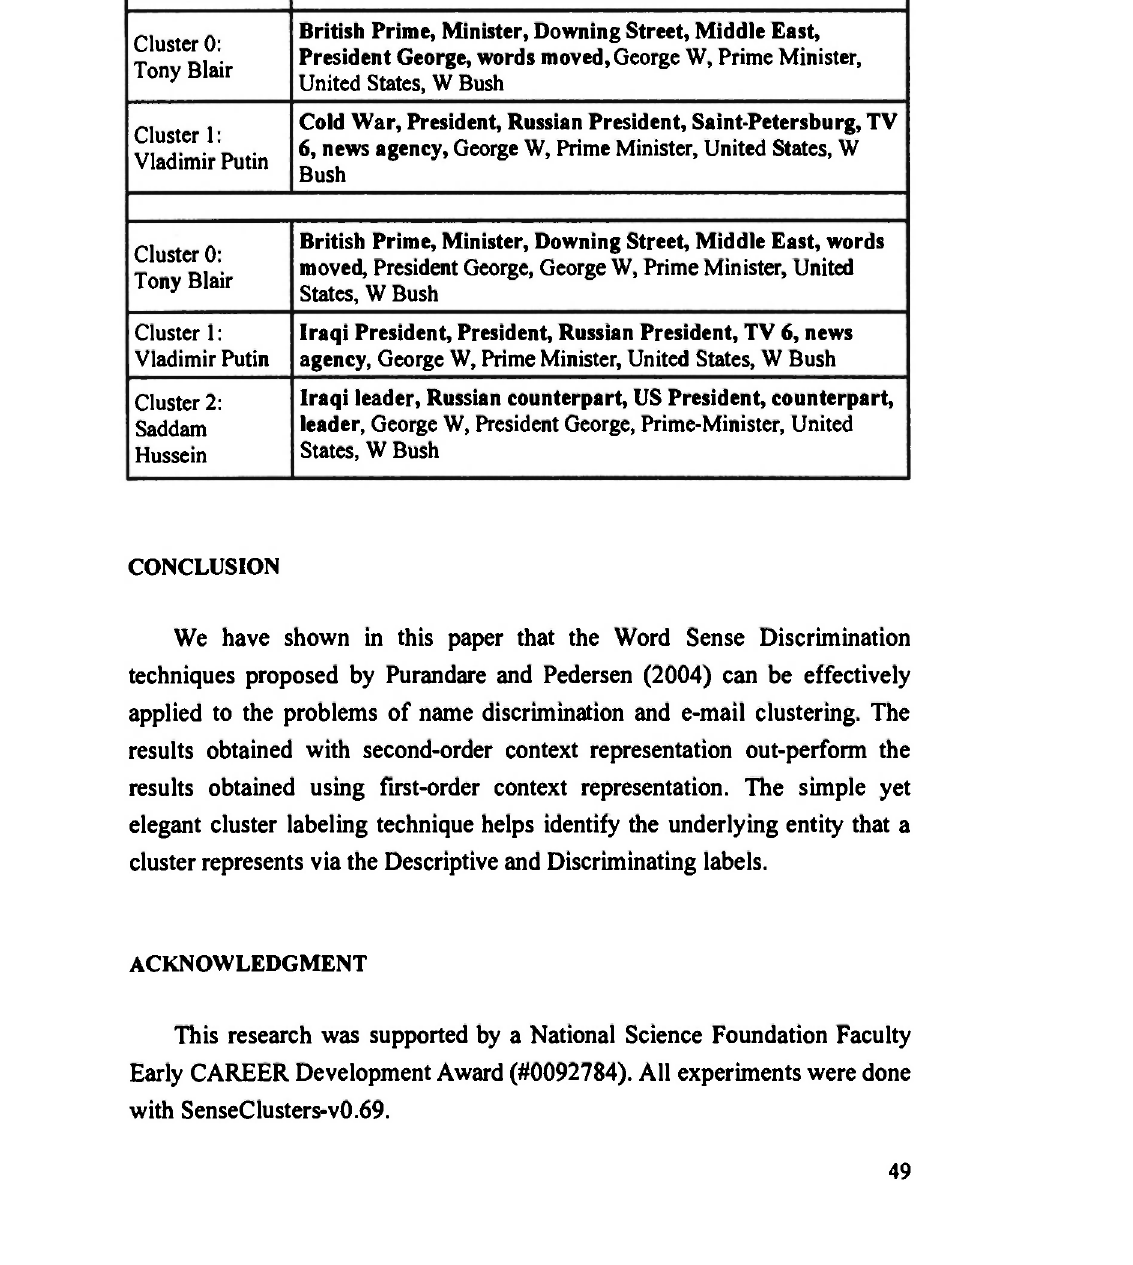
Cluster labels for the 2-way experiment- Tony Blair and Vladimir Putin, for the 3-way experiment- Tony Blair, Vladimir Putin and Saddam